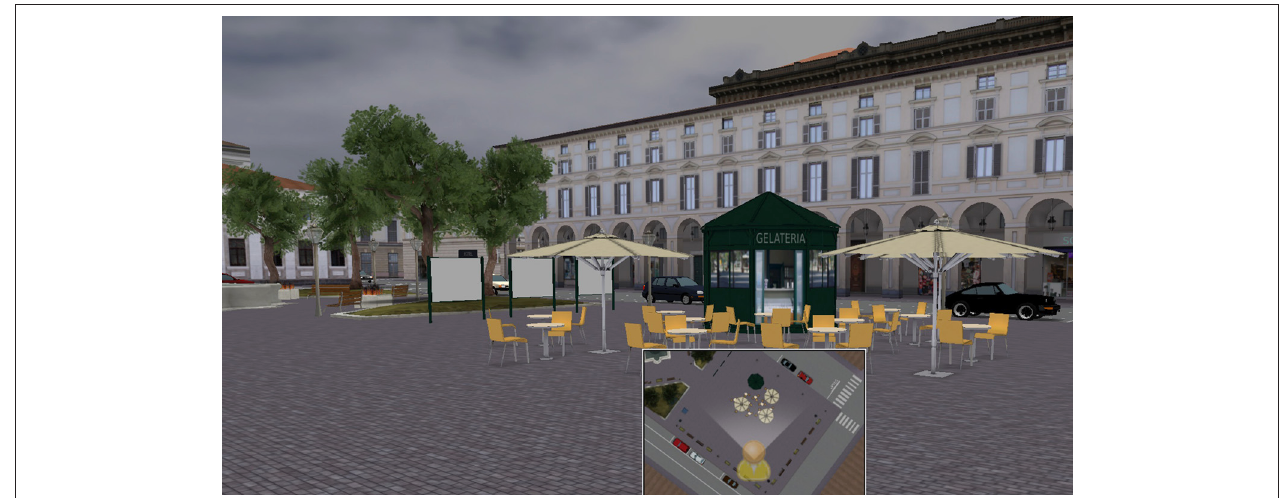
FIGURE 4 | During the retrieval phase, to facilitate the retrieval of spatial information, an interactive aerial view of the virtual city was presented during the navigation and the display was oriented depending on the participant’s movement in the virtual world.